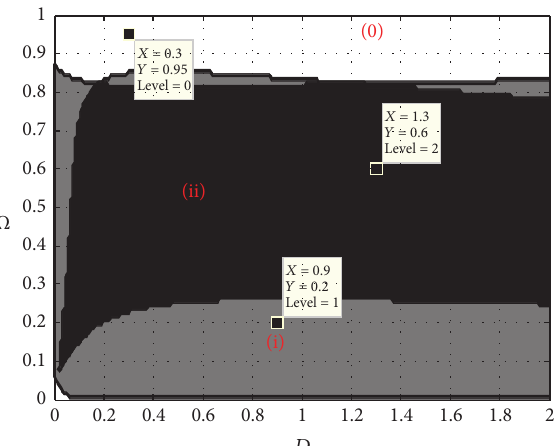
Figure 2: The phase diagram for the stochastic resonance behaviors of the output amplitude 𝐴(𝑎 2 ) at 𝜔 2 0 = 1 , 𝐴 1 = 1 , 𝐻 = 0.55 , 𝐴 2 = 1 , 𝛾 = 0.3 , and V = 0.01 , and the values of Level in Figure 2, reflect the number of SR peaks for different combination of 𝐷 and Ω .